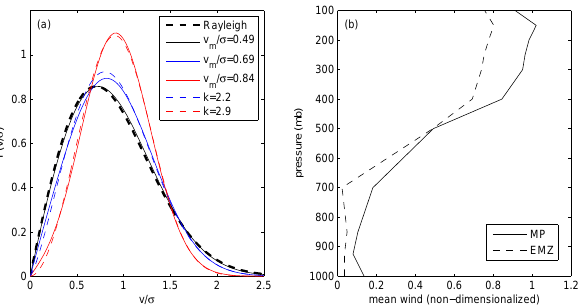
Fig. 4. (a) The Rayleigh distribution (bold dashed) is compared to the PDF of wind speed when the mean wind v m is non-zero (solid) assuming Gaussian wind anomalies. Examples of Weibull distri- butions with k > 2 (dashed) are also shown for comparison. Wind speed v is normalized by its rms value σ for each distribution to facilitate comparison. (b) Normalized mean wind v m /σ for the set of 7 stations on Malay Peninsula (MP) and mean normalized wind u m for Equatorial Monsoon Zone (EMZ), where u = v/σ for each